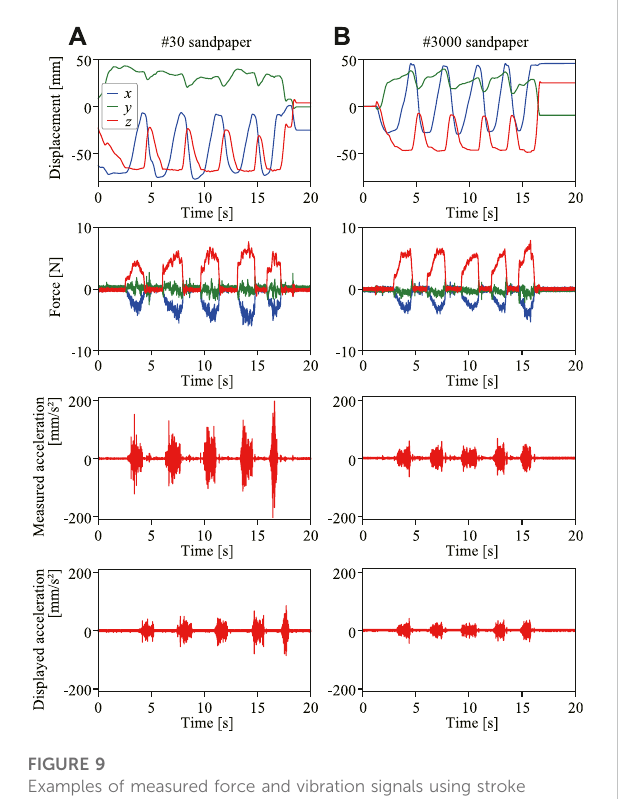
FIGURE 9 Examples of measured force and vibration signals using stroke touch mode in Experiment